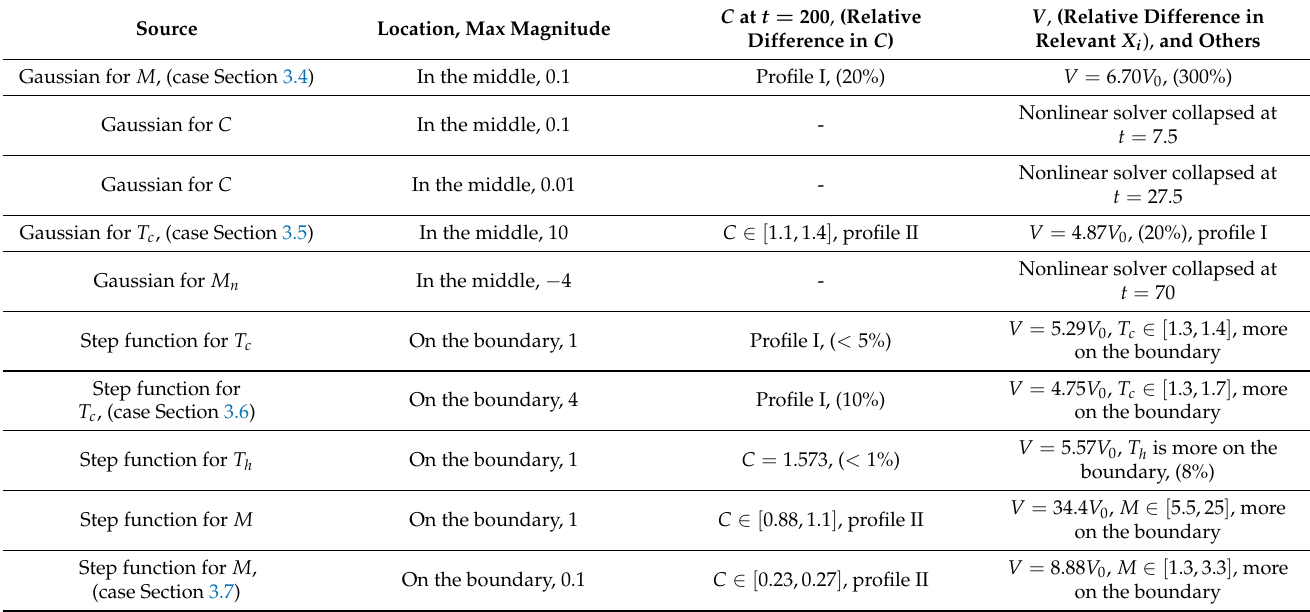
Table A5. A report of different experiments using uniform initial condition and no-flux boundary